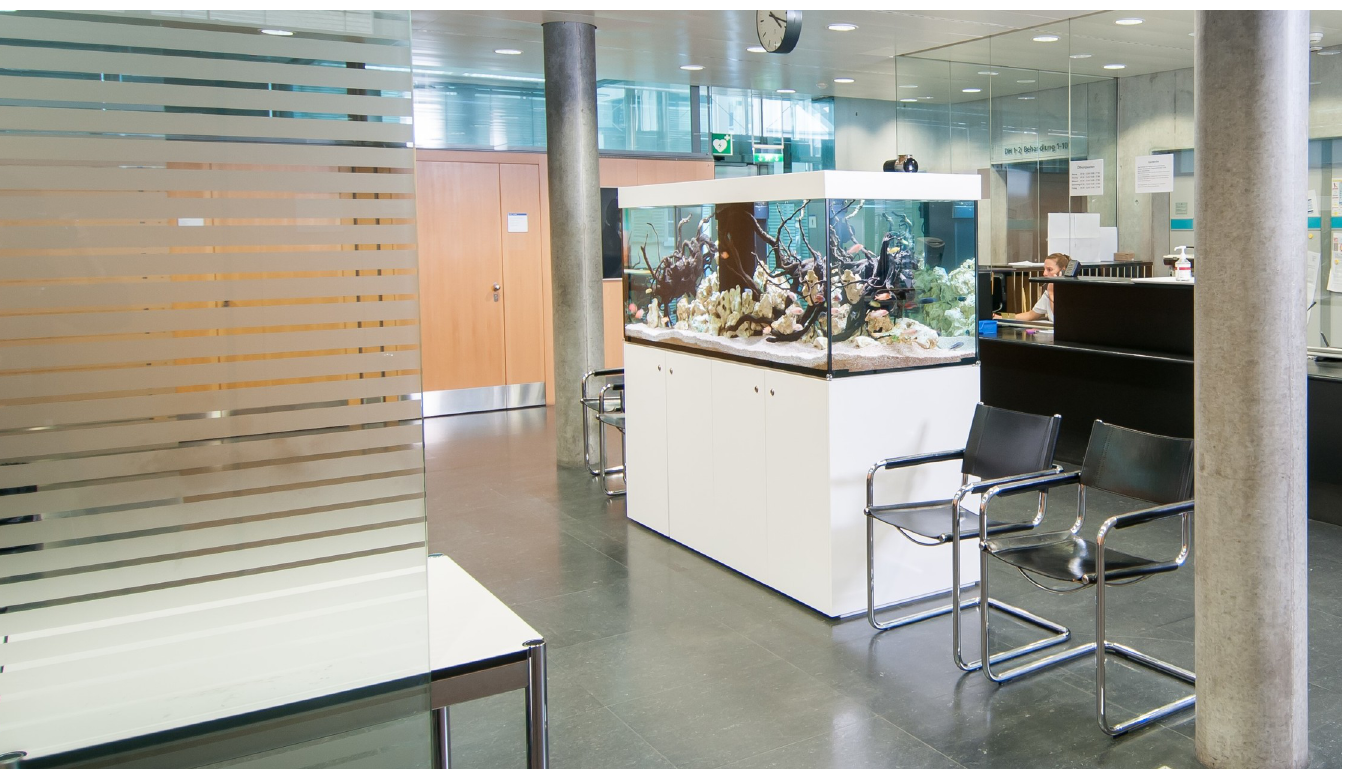
Fig 4. Waiting area with fully stocked aquarium with fish.